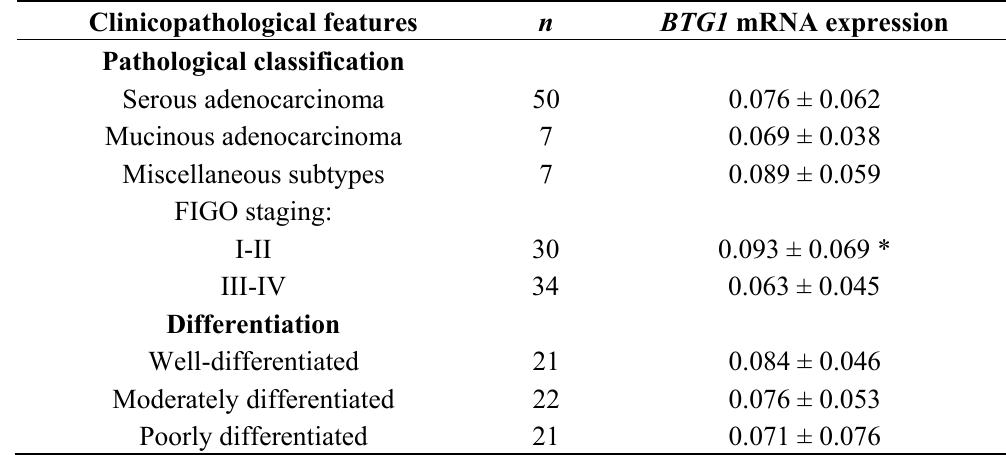
Table 2. Correlation of BTG1 mRNA expression with tumorigenesis and aggressive features of ovarian